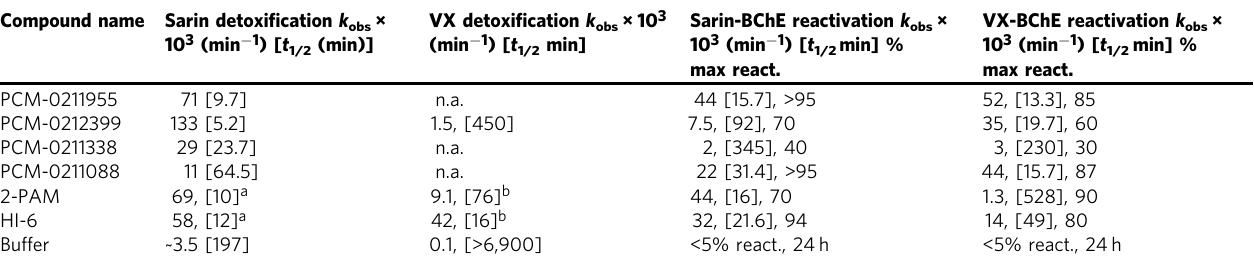
Detoxi fi cationof VXandsarin(1 µ M)byoxime(0.5mM),including2-PAMandHI-6ascontrols.Detoxi fi cationofsarinwasmeasuredwith1 µ M sarin and0.5mMoxime,20mMphosphate,pH 8,25°C. In the reactivation experiments [VX] = 1.0×10 − 6 M and [sarin] = 3.0×10 − 6 M were used for BChE inhibition. HuBChE (2.0×10 − 6 M) was incubated with either VX or sarin until reaching a steady 90 – 95% BChE inhibition, before diluting the OP-BChE conjugate 100-fold into oxime or buffer solution, ([oxime] = 0.5mM), 10mM phosphate pH 8.0, 25°C. n.a. Not active a Ref. 26 measured with sarin 1.5mM and 15 µ M oxime, 100mM MOPS, pH 7.4, 25°C. b Ref. 27